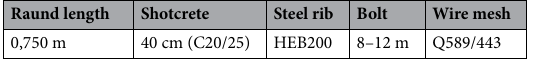
Table 5. C3 support system